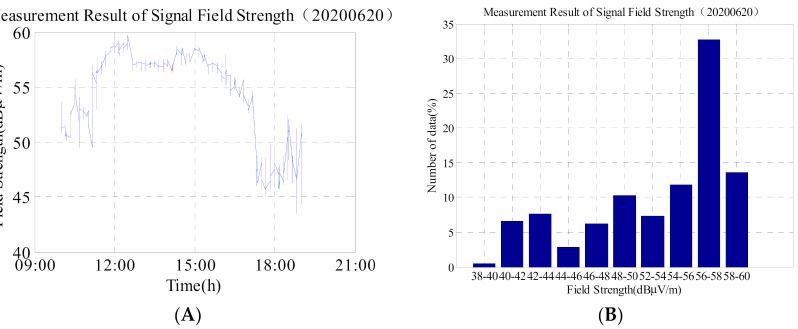
Figure 5. ( A ) Field strength change of low-frequency time-code signal on 20 June 2020; and ( B ) corre- sponding histogram. Total number of data is 1163.